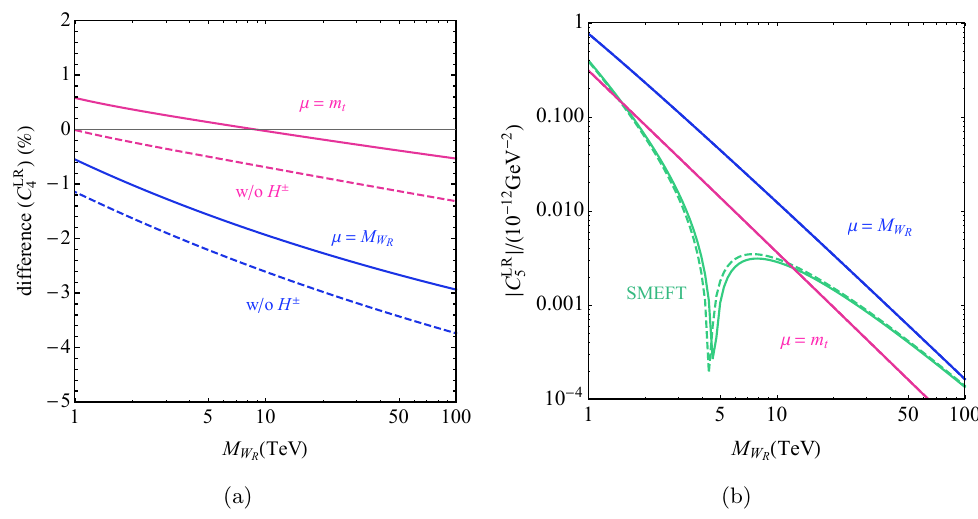
Figure 3 . The low-scale Wilson coe(cid:14)cients C 4 ( M W in comparison with the conventional results. In the conventional approach, the Wilson coe(cid:14)- cients, (3.6){(3.9), are input at (cid:22) = M W include the contribution from the heavy charged Higgs boson.